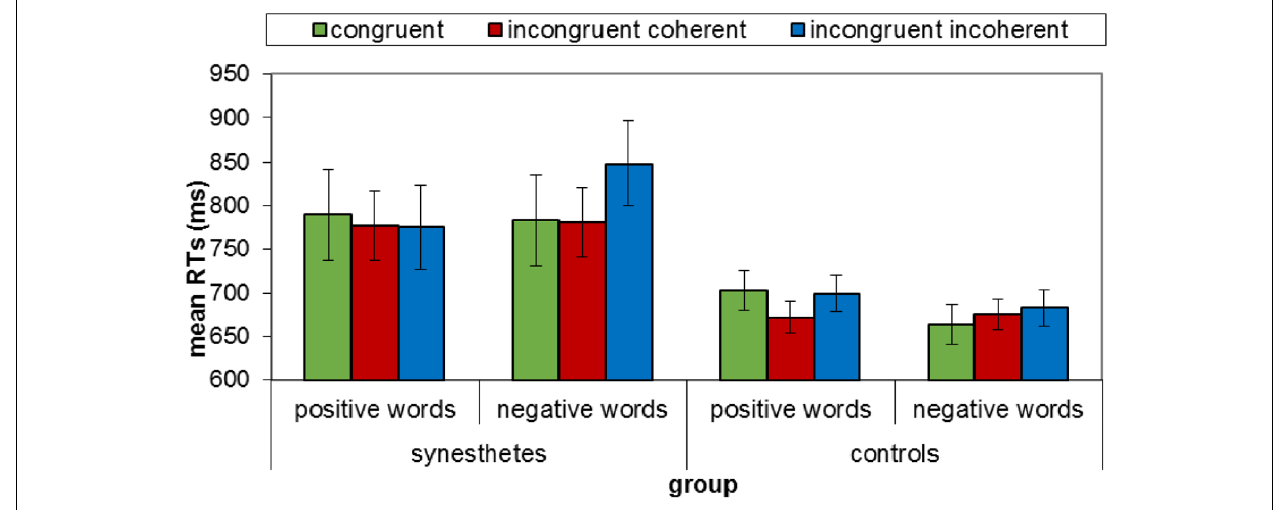
FIGURE 6 | Mean RT for synesthetes (AD and BM) and control groups for valenced words (positive vs. negative) in the various congruity conditions (congruent, incongruent coherent, incongruent incoherent) in Experiment 2. Error bars denote standard error of the mean.